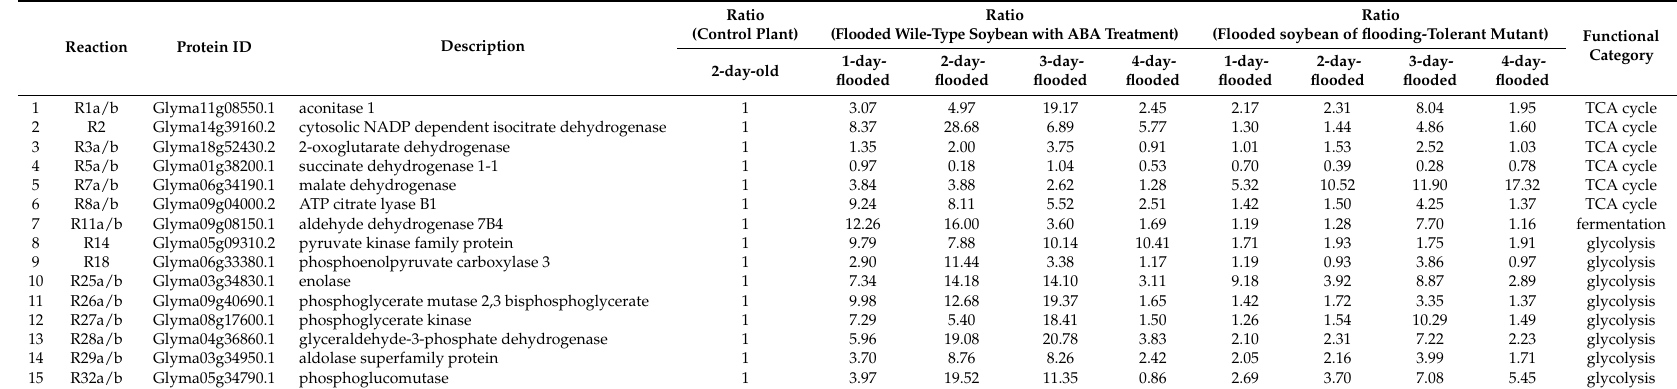
Table 2. Ratio of commonly changed proteins related to glycolysis, fermentation, and tricarboxylic acid cycle in ABA-treated wild-type soybeans and flood-tolerant mutant plants under flooding